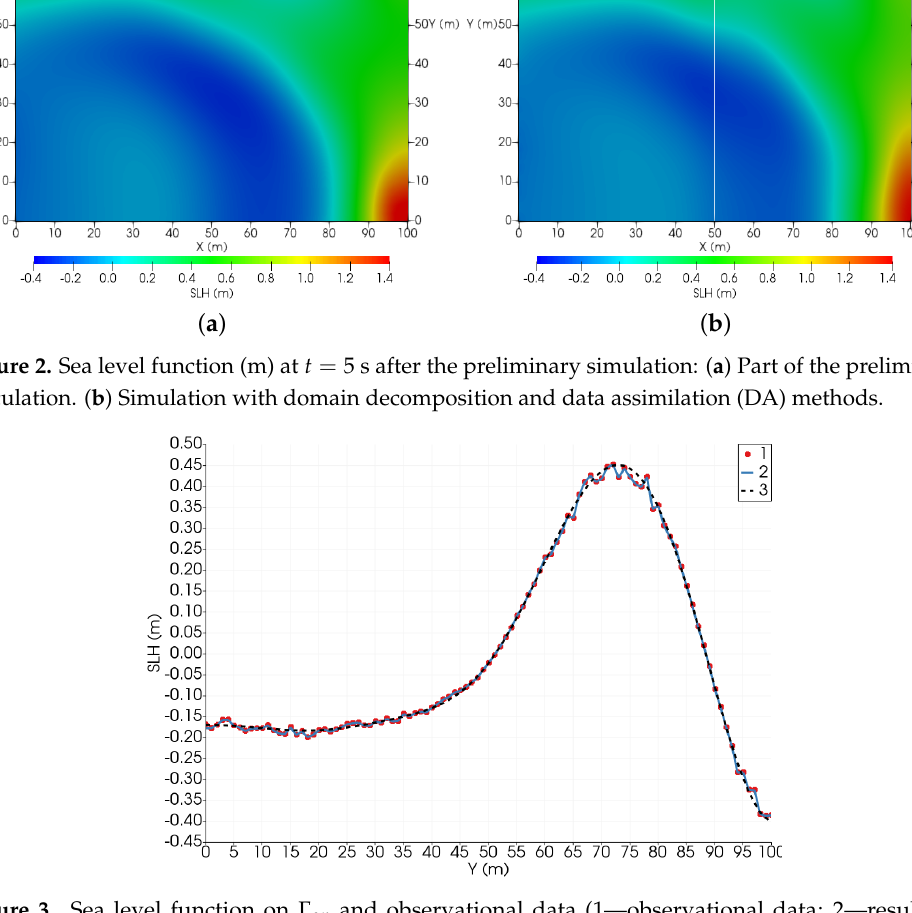
Figure 3. Sea level function on Γ op and observational data (1—observational data; 2—results of simulation; 3—results of the preliminary